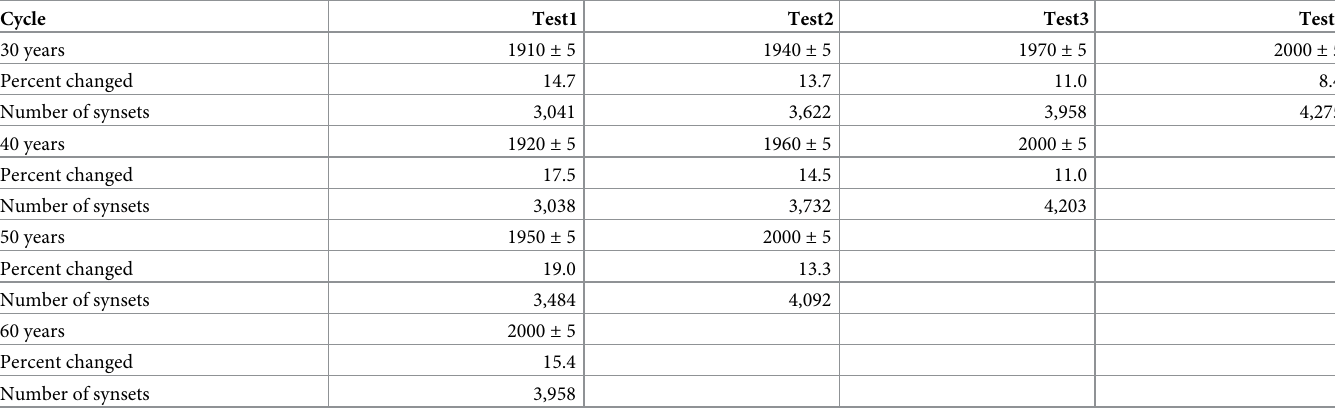
Table 10. The effect that varying cycle lengths has on the percentage of synsets that have changed leadership from present to future